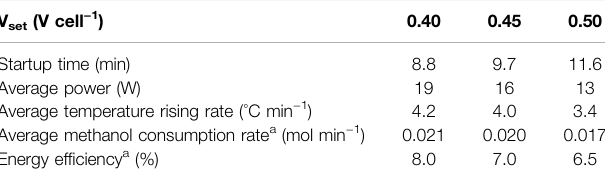
TABLE 2 | Parameters of DMFC startup at various initial discharge voltages. C ini : 0.3 mol L − 1 ; T ini : 23 ° C; Δ I set : 0.5